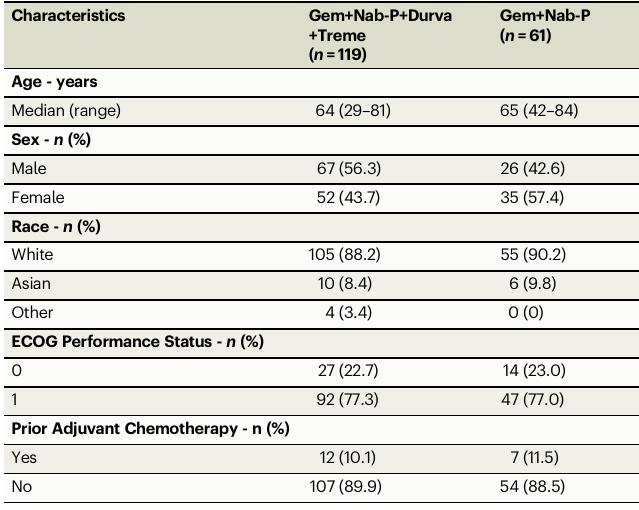
Table 1 | Baseline characteristics of intention-to-treat study population